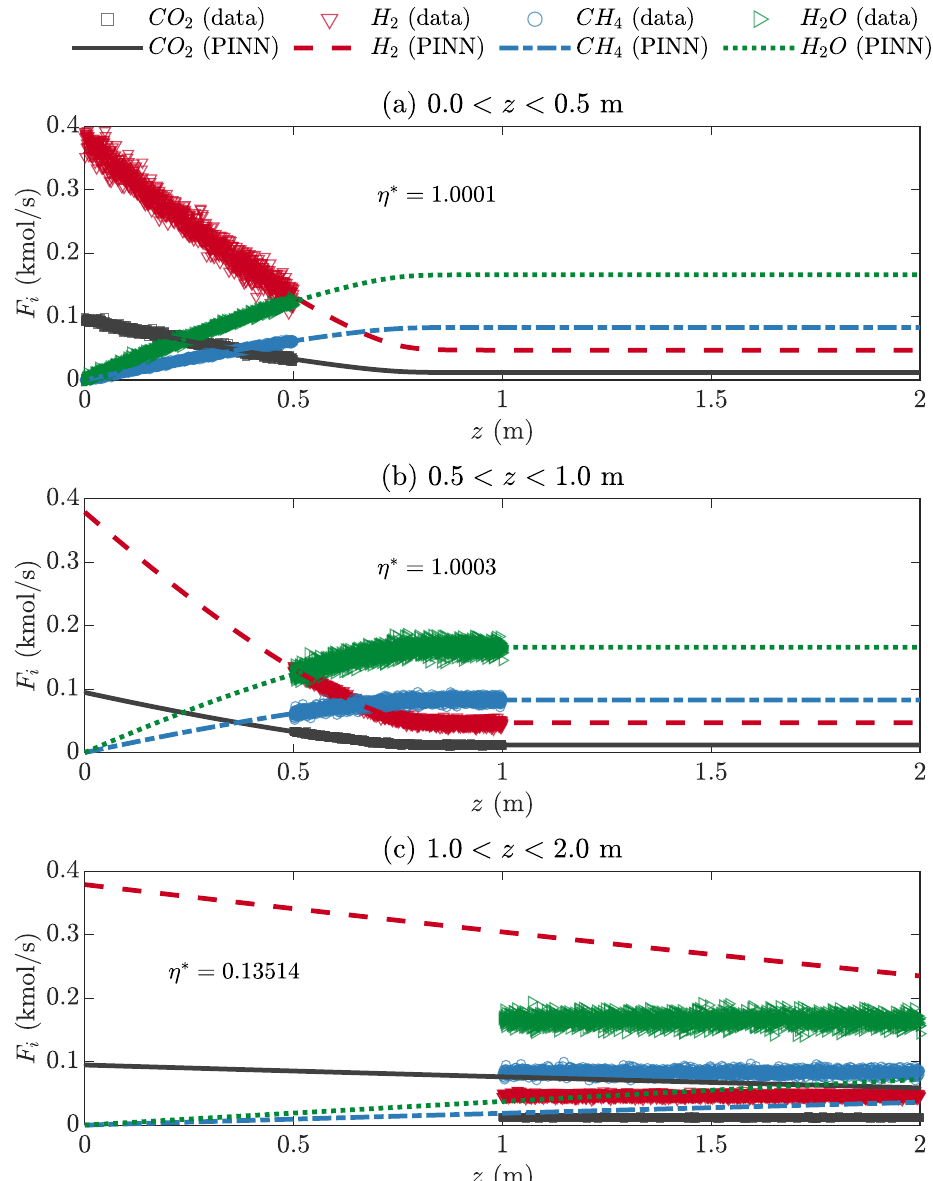
Figure 11. Performance of the inverse PINN model with seven hidden layers, 256 neurons, and the tanh activation function for 1000 observation data points in a limited range of the reactor length ( z ): ( a ) 0 < 𝑧 < 0.5 m, ( b ) 0.5 < 𝑧 < 1.0 m, and ( c ) 1.0 < 𝑧 < 2.0 m.